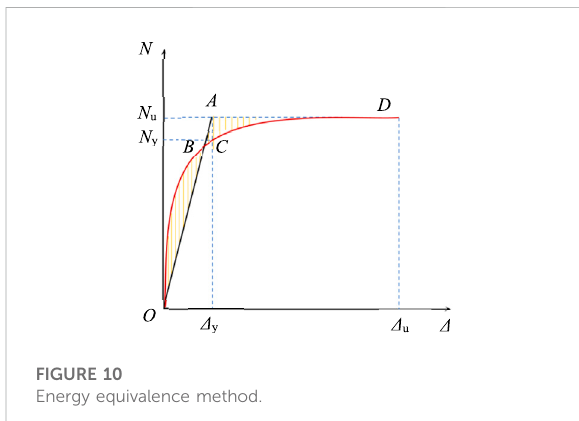
FIGURE 10 Energy equivalence